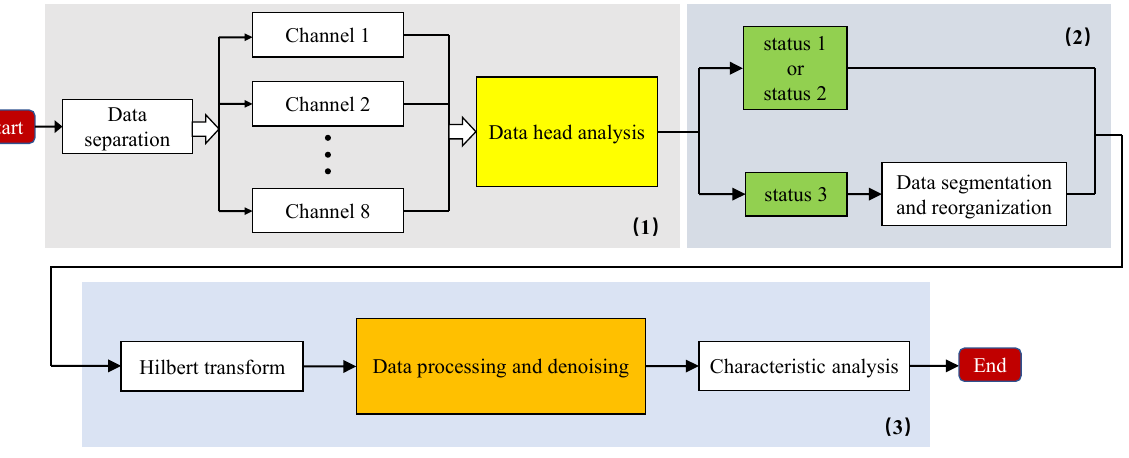
Figure 4. Data preprocessing flowchart.